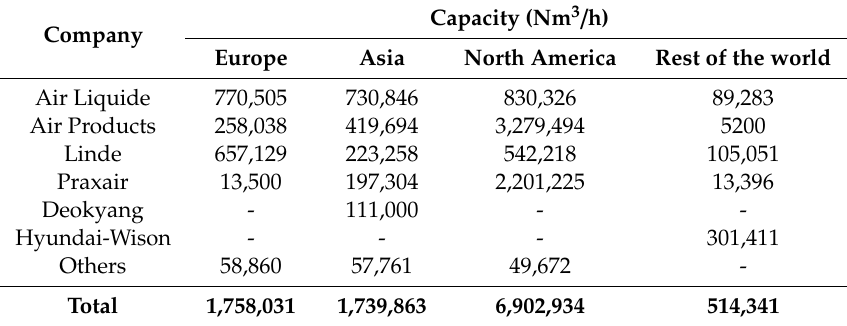
Table 1. Hydrogen production plants